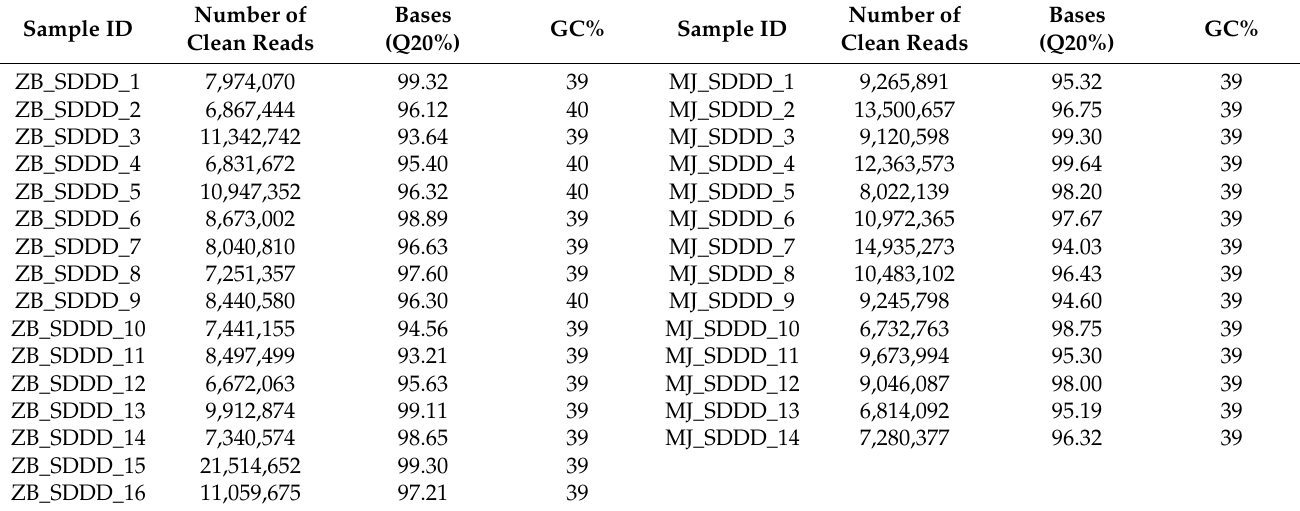
Table 2. Statistics for the genomic data obtained from 30 L. kasmira individuals.